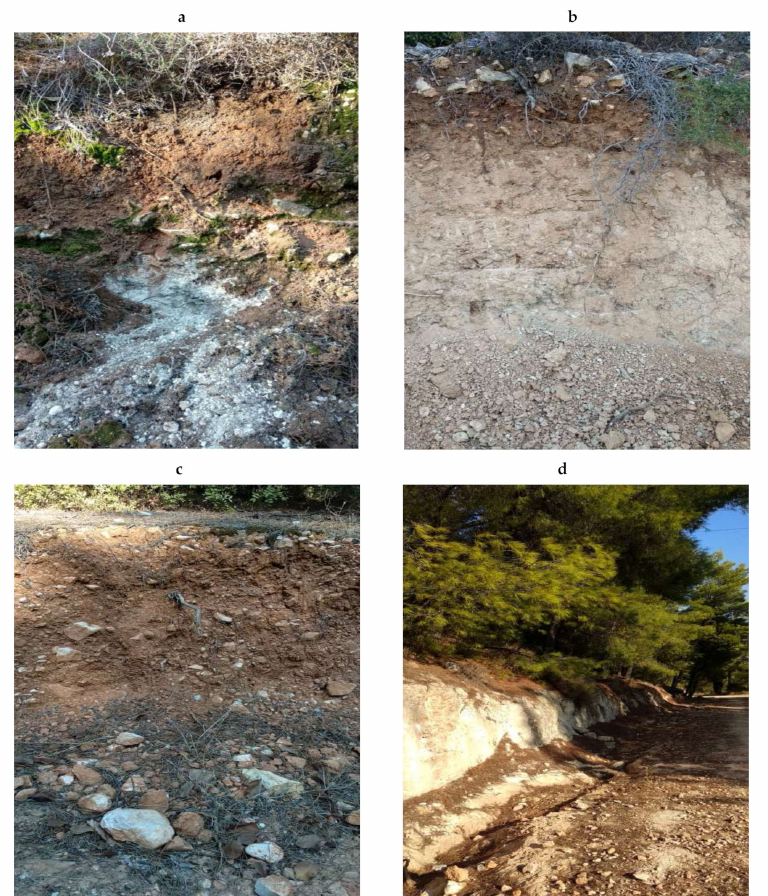
Figure 5. Representative soil profiles described in 2019: ( a ) Cambisol formed on limestone parent material with calcic horizon (Profile P1), ( b ) Cambisol formed on limestone parent material with a petrocalcic horizon at the depth > 80 cm (Profile P2), ( c ) Cambisol formed on limestone parent material rich in rock fragments (Profile P3), ( d ) Leptosol formed on limestone parent material with bedrock at depth ≥ 20 cm (Profile